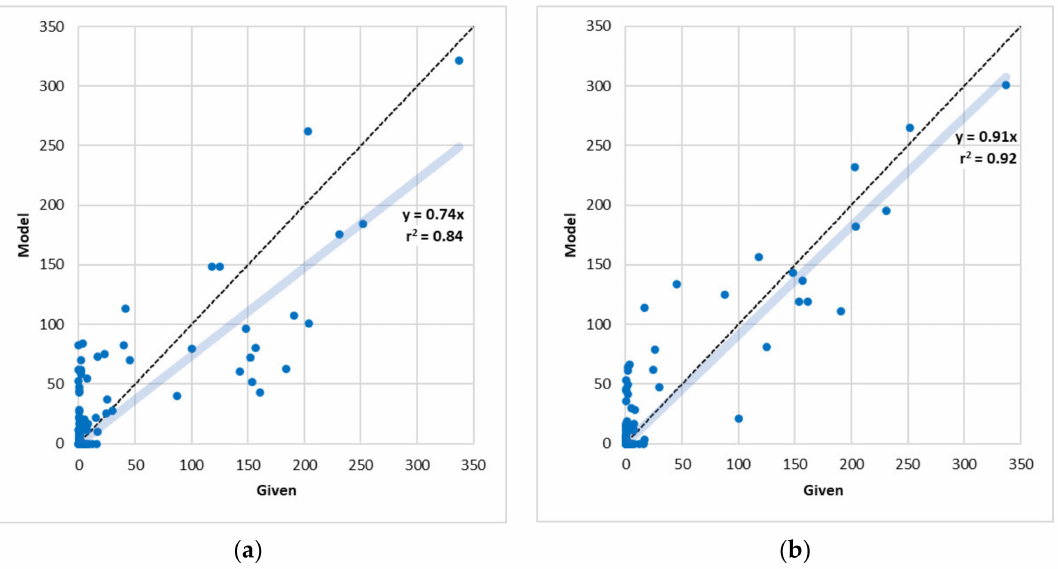
Figure 14. Plot of given and modelled Fe 3+ values based on ( a ) Sentinel-2 Level-1C TOA products and ( b ) Sentinel-2 Level-2A BOA